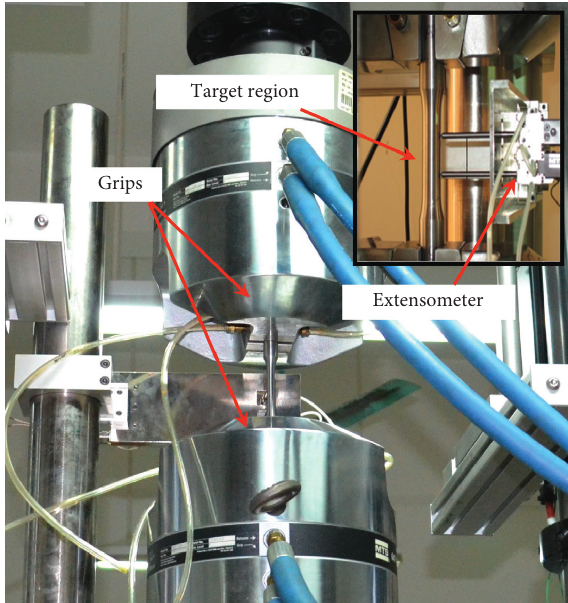
Figure 2: Test setup for the study of the material behavior.